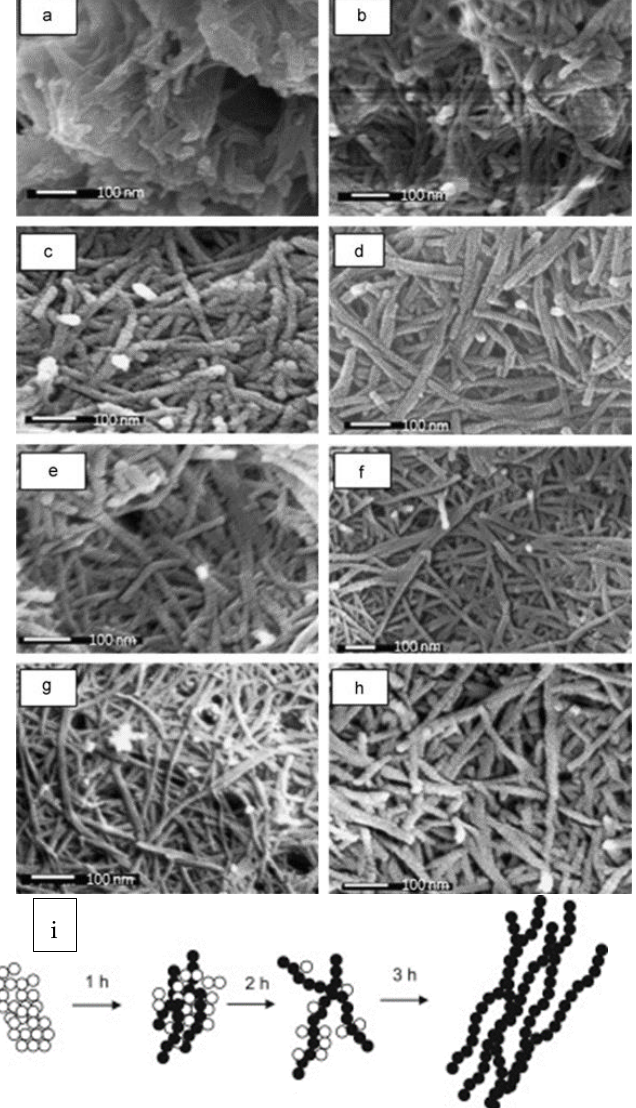
Figure 5. Large-scale hydrothermal synthesis is explored to produce surfactant-free seed mediated mesoporous TiO 2 nanowires by Asiah et al. ( a – h ) FESEM micrographs of TiO 2 nanowires at di ff erent growth time, ( a ) 1 h, ( b ) 2 h, ( c ) 3 h, ( d ) 4 h, ( e ) 5 h, ( f ) 6 h, ( g ) 8 h and ( h ) 10 h, respectively. ( i )